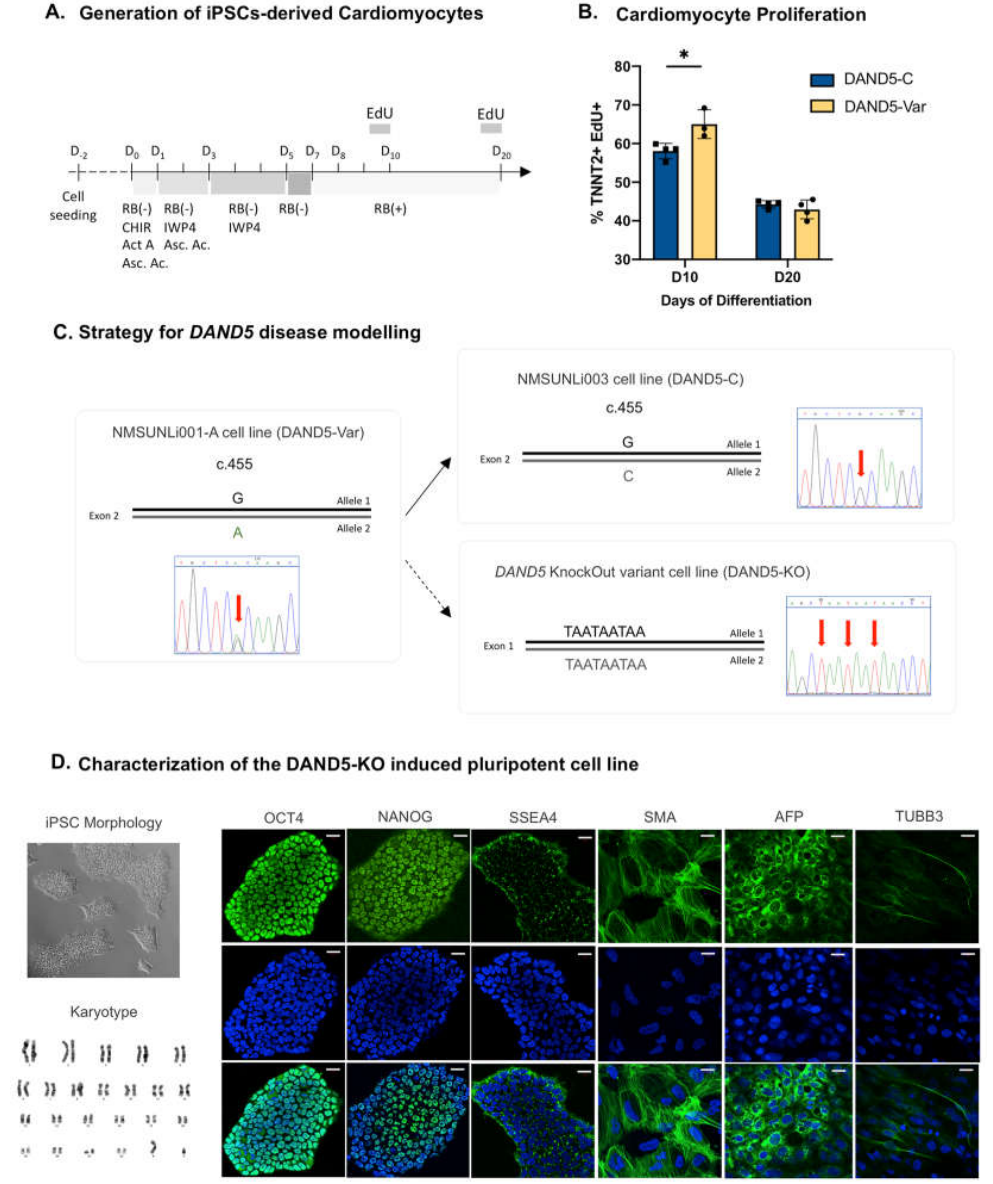
Figure 1. DAND5 disease modelling setting. ( A ) Schematic representation of the differentiation pro- cess, depicting the small molecules added and EdU incubation. ( B ) Analysis of TNNT2-positive cell proliferation in DAND5-Var (yellow) vs. DAND5-C (blue) iPSC-CM by labelling newly synthesised DNA using EdU incubation for 17 h. The relative fluorescence intensity of cells was analysed by flow cytometry at day 10 (D10) and 20 (D20) of differentiation. ( C ) Strategy used for the generation of the different hiPSCs using CRISPR/Cas9 technology. ( D ) Characterisation of DAND5-KO cell line: Left panel—(top) bright-field image of the DAND5-KO cell colonies morphology; (bottom) representative metaphase showing normal 46 chromosomes (XY) karyotype. Middle panels—immunodetection of undifferentiated markers OCT4 , NANOG and SSEA4 of DAND5-KO hiPSCs (scale bar: 40 µ m). Right panels—immunofluorescence for endodermal marker α -fetoprotein (AFP), ectodermal marker β III-tubulin (TUBB3) and mesodermal marker α -smooth muscle actin (SMA) showing DAND5-KO hiPSCs trilineage differentiation potentiality (scale bar: 20 µ m). Nuclei were stained with DAPI. All the results represent the mean ± SD of three independent biological experiments. Unpaired Student’s t-test was applied to compare the differences between DAND5-C and DAND5-Var groups on each day of differentiation. Statistically significant results were considered when * p <